Question: Identify the chart type used in this figure.
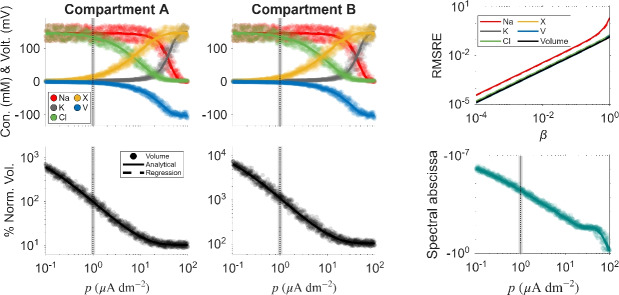
Answer: scatter